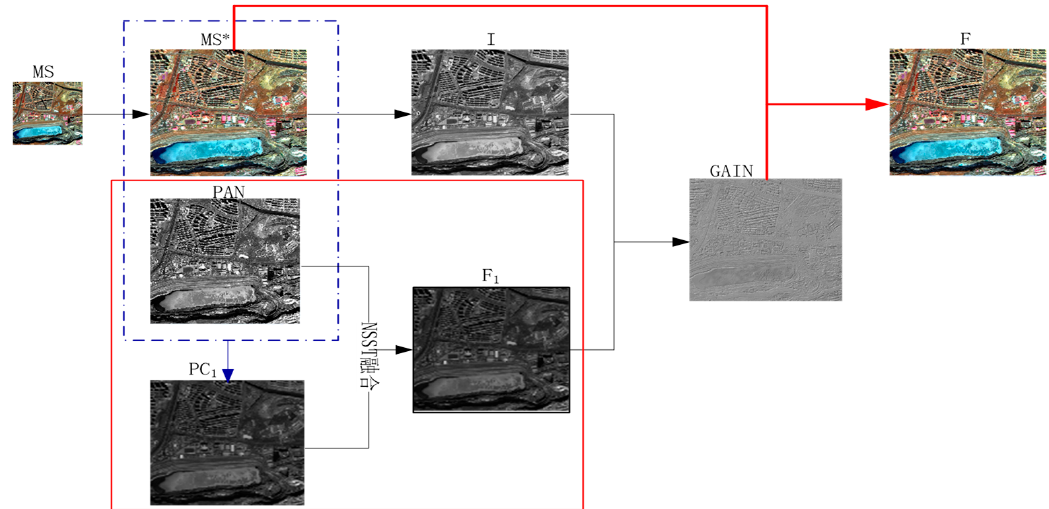
Figure 2. Flowchart of the proposed method.